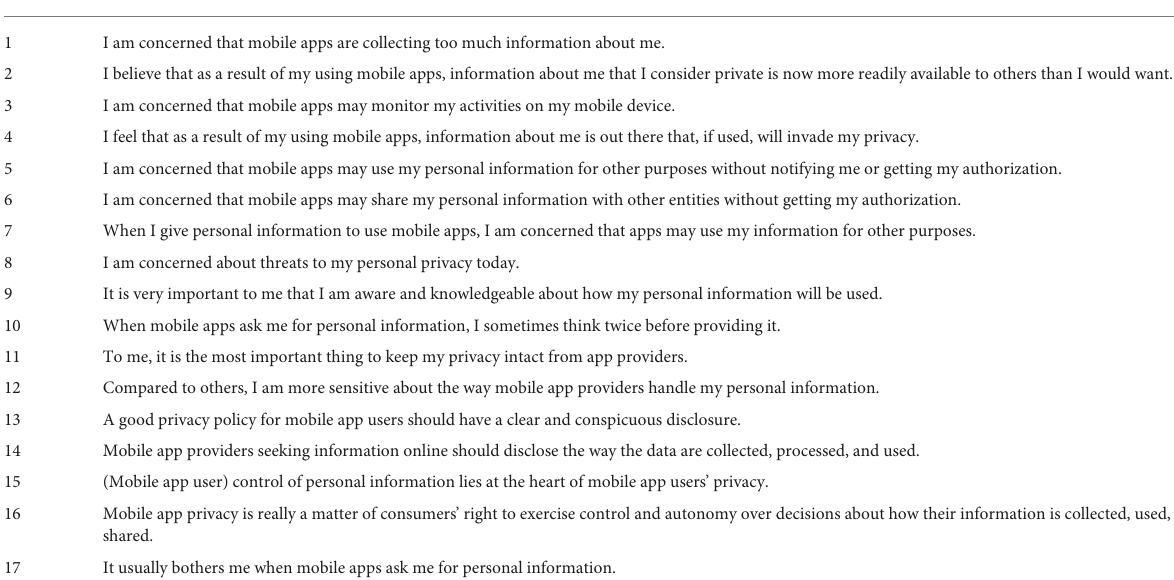
TABLE 1 Items of the app information privacy concerns